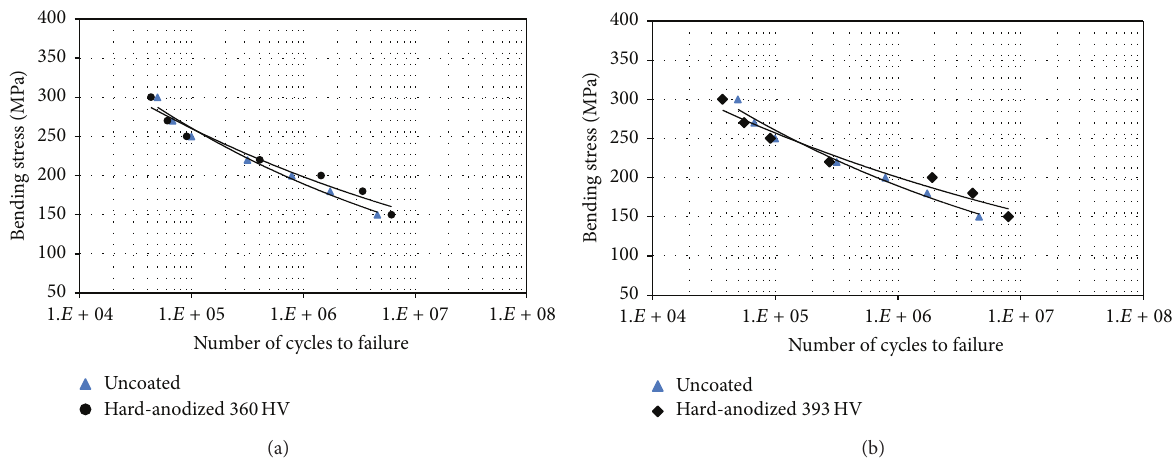
Figure 18: Comparison of S/N curve of fretting fatigue for uncoated and hard-anodized specimen. (a) S/N curve of fretting fatigue for uncoated and hard-anodized specimens (360HV) and (b) S/N curve of fretting fatigue for uncoated and optimum hard-anodized parameters specimens (393 HV)